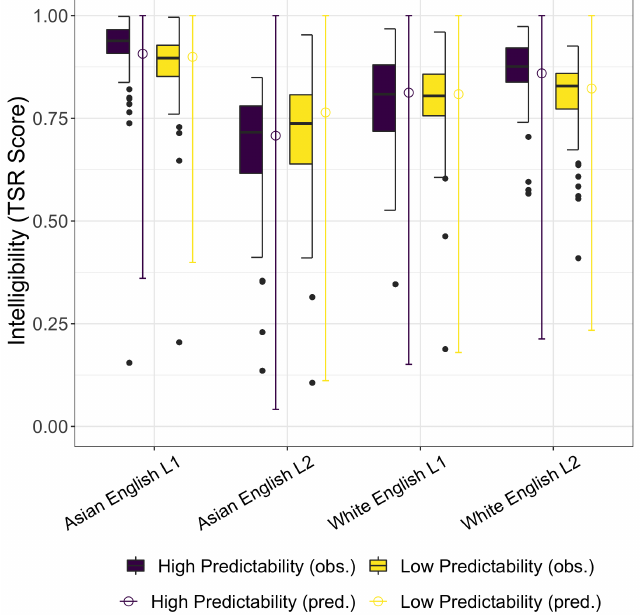
Figure 1. A box-and-whisker plot of the empirical results and the range of the posterior predictive distributions for intelligibility, plotted as TSR scores, for the four talkers separated by high and low predictability